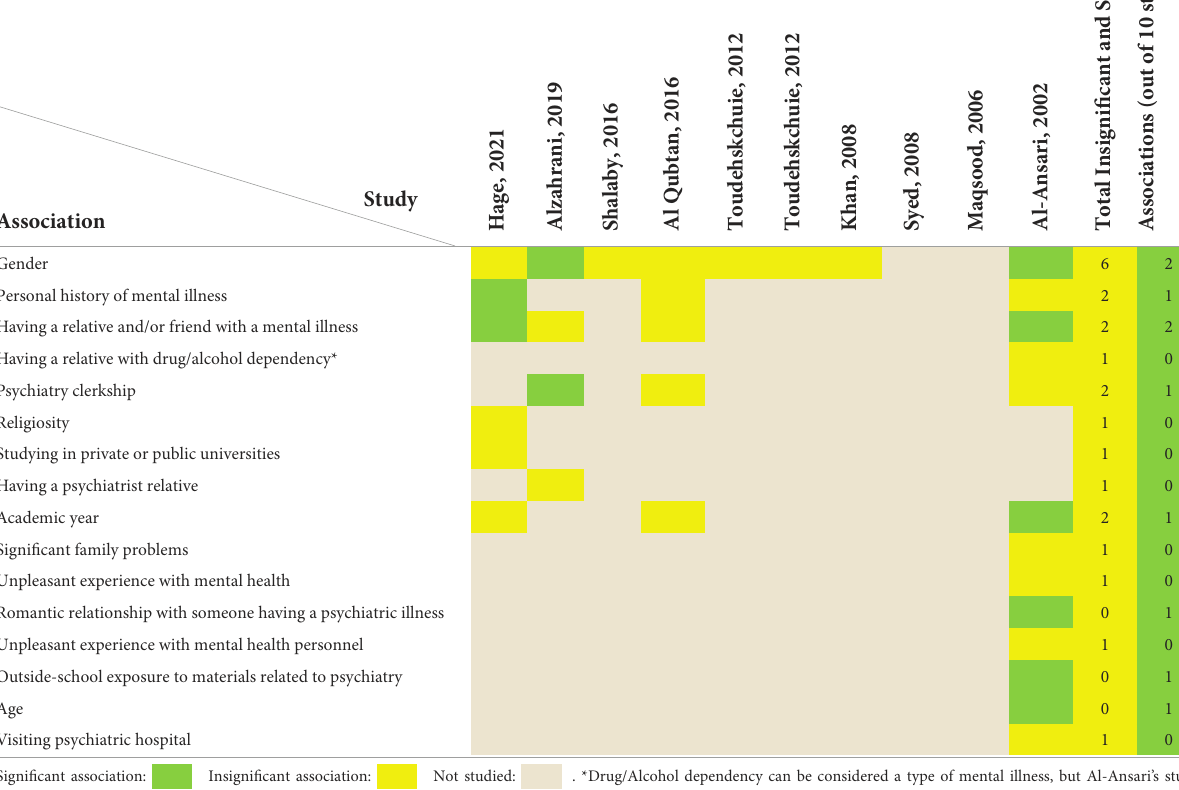
TABLE 3 Summary of factors affecting attitudes toward psychiatry in the review of studies assessing the stigma toward psychiatry among medical students in the Eastern Mediterranean Region.